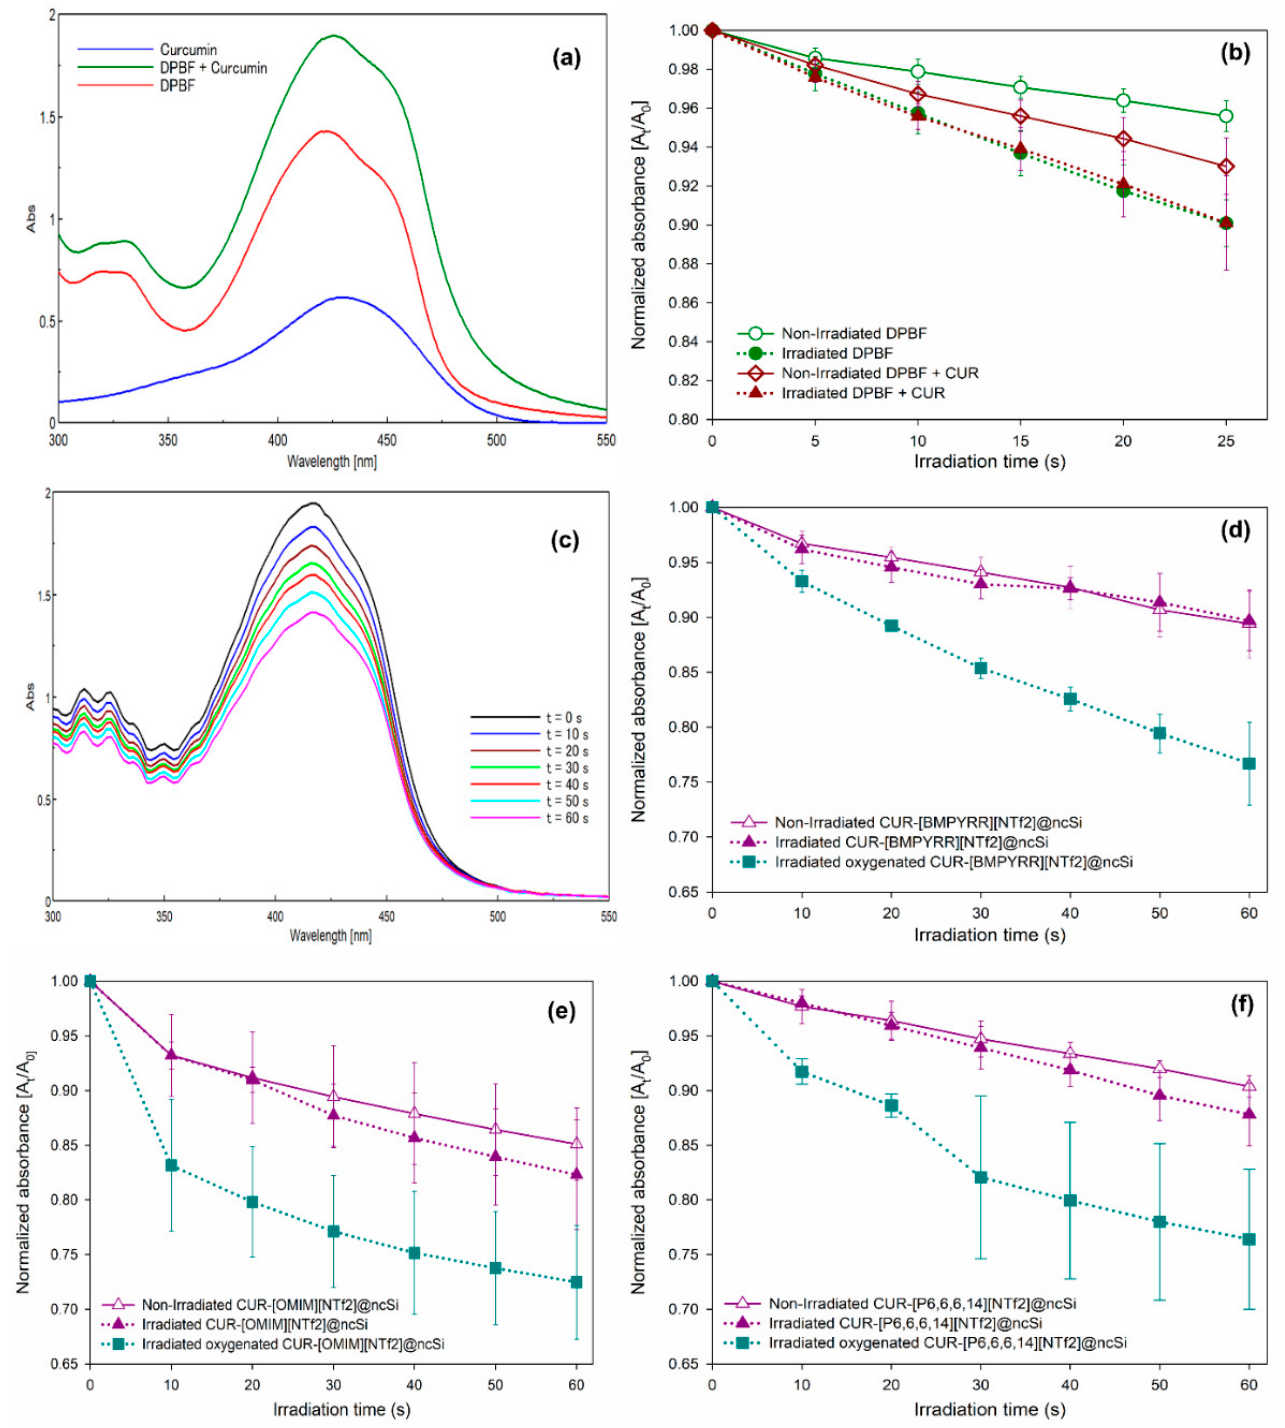
Figure 6. Singlet oxygen, 1 O 2, detection by a chemical probe (DPBF) in aerated and oxygen-saturated (oxygenated) solutions or suspensions: ( a ) UV-VIS absorbance spectrum of DPBF, curcumin,